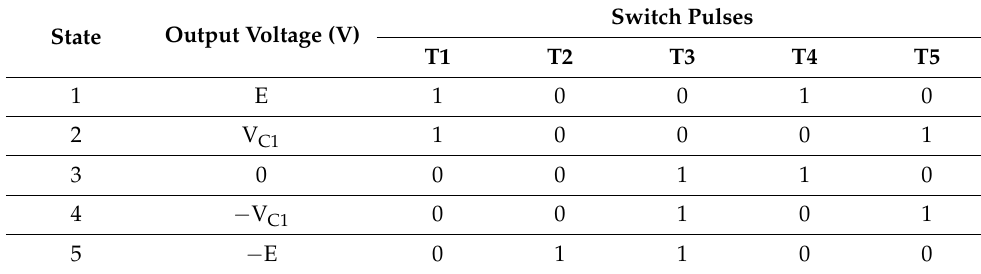
Table 2. SPUC5 inverter switching sequence.